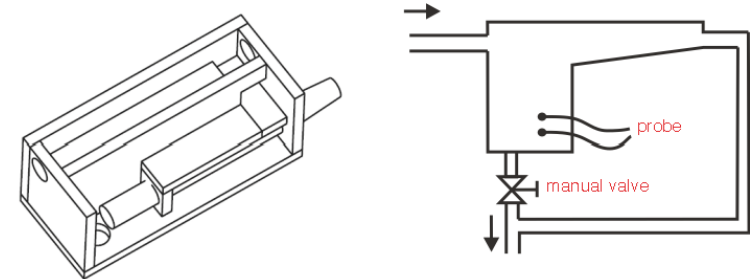
Figure 7. CAD drawing of one of the boxes. Scheme of the inlet and outlet ports.